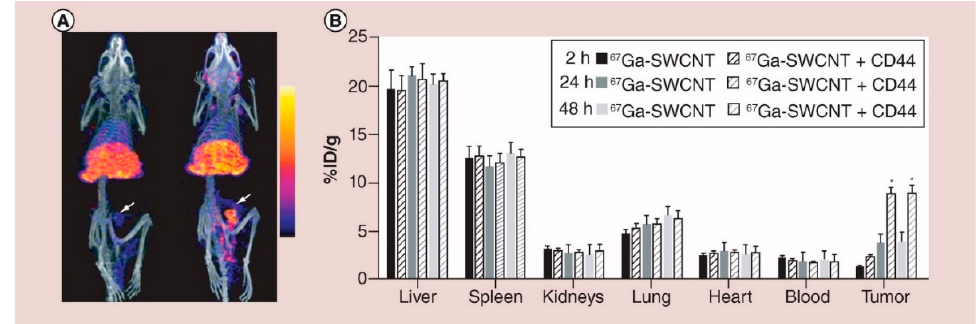
Figure 2. Biodistribution of Gallium-67-labeled single-walled carbon nanotubes in murine breast cancer model. ( A ) SPECT/CT images of tumor-bearing mice after 24 h of injection of either Ga- SWCNT or Ga-SWCNT + CD44 (right). ( B ) Quantitative measurement of radioactivity of Ga-SWCNT or Ga-SWCNT + CD44 at various organs and tumor after dosing at different time points: 2, 24, and 48 h represented as dose per gram of tissue. Image reproduced with permission from [134]. Copyright 2016 Future Medicine Ltd.